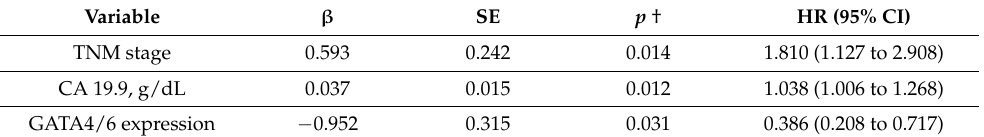
Table 4. Variables significantly associated with disease free survival in the Cox regression